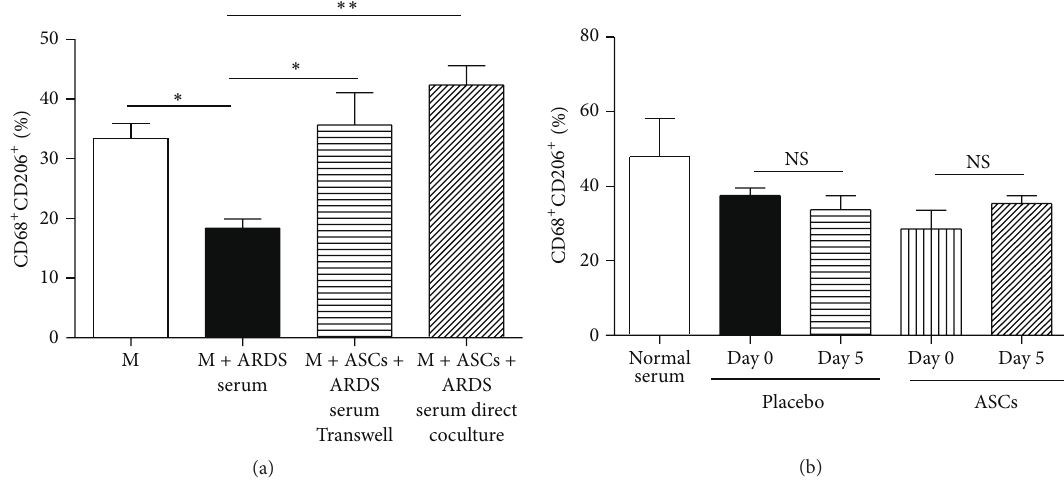
Figure 5: ASCs increase the levels of CD68 + CD206 + macrophages treated with ARDS serum. (a) Peritoneal macrophages (M) (2 × 10 6